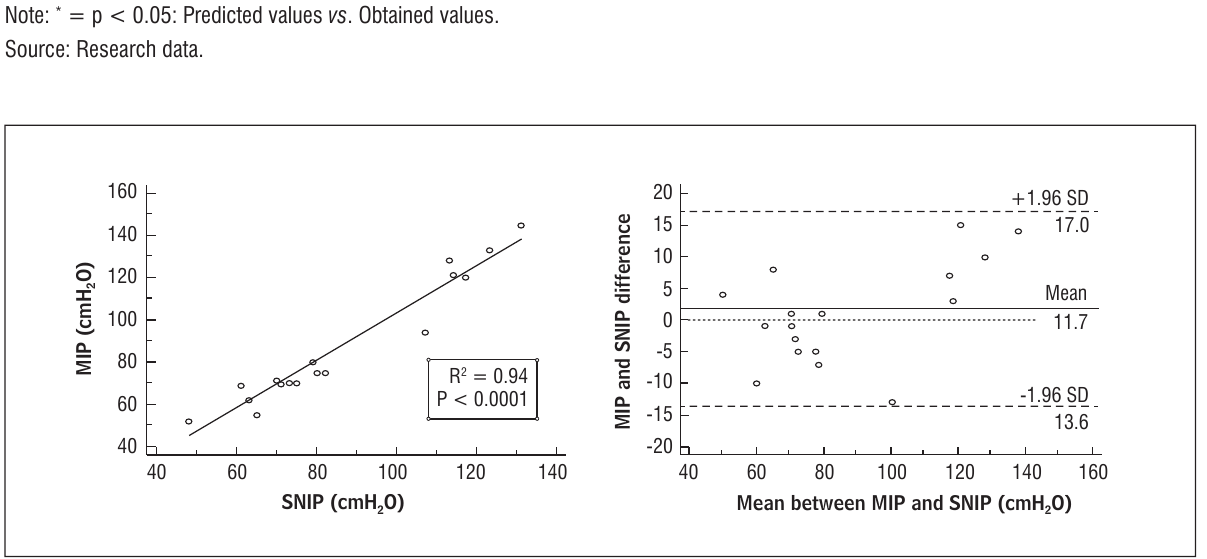
Figure 1 - Graphical representation of the correlation analysis between Maximal inspiratory pressure (MIP) and Sniff nasal inspiratory pressure (SNIP), in cmH O, and scatter plot for the difference and mean between and MIP and SNIP 2 variables of the 17 tetraplegic volunteers studied Source: Research